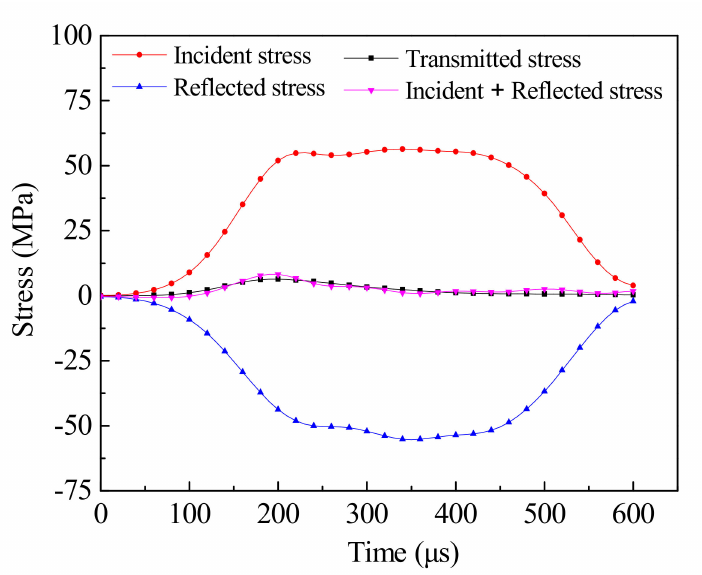
Figure 8. Verification of stress